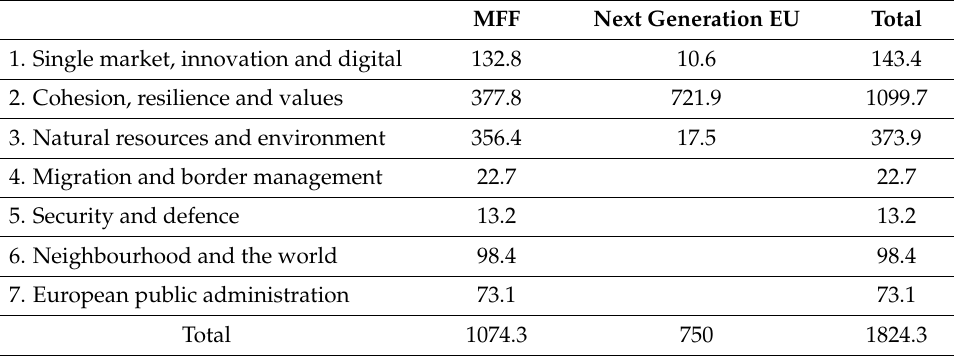
Table 2. Multiannual Financial Framework (MFF) 2021–2027 total allocations by heading (in billion EUR, in constant 2018